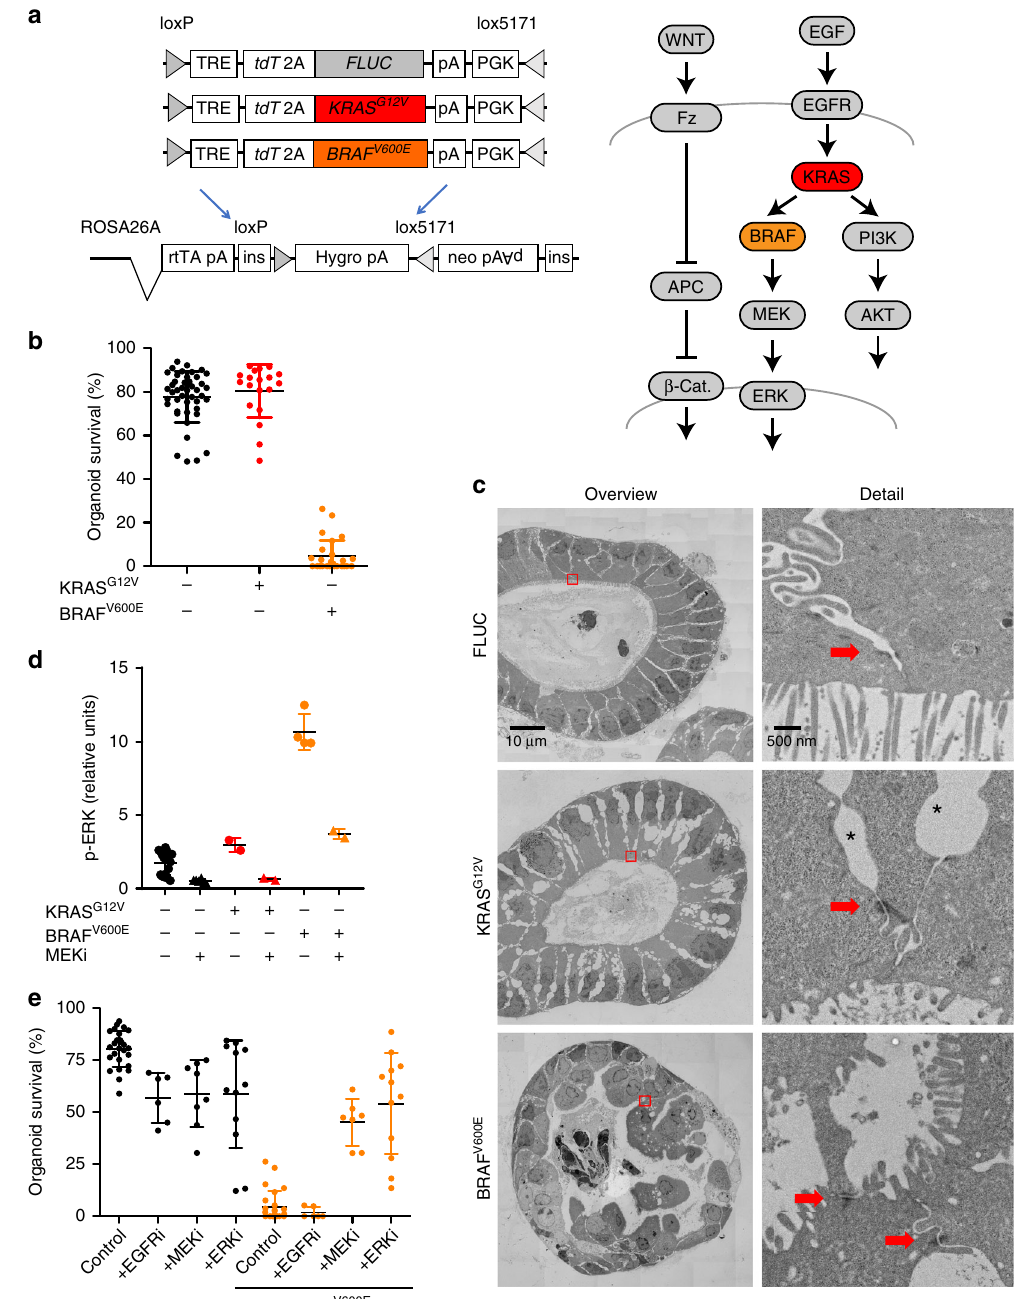
Fig. 2 Transgenic BRAF V600E , but not KRAS G12V disrupts organoids due to high ERK activity. a Simpli fi ed representations of transgenes and the RAS-ERK and Wnt/ β -catenin pathways, indicating relative positions of the KRAS and BRAF proto-oncogenes. b Organoid survival 4 days after induction of oncogenic KRAS G12V or BRAF V600E . Organoids are counted immediately after passaging, and fractions of surviving organoids were calculated at day 4. Control organoids comprise of mixed non-induced cultures of KRAS G12V and BRAF V600E lines. c Electron microscopy reveals loss of epithelial integrity after BRAF V600E induction. Images of the intestinal organoid epithelium, 24 h after induction of control FLUC, KRAS G12V or BRAFV 600E transgenes. Detailed views (right) represent a zoom into areas marked by red boxes in the overviews (left). Detailed views show apical surfaces of adjacent enterocytes with brush border. Red arrows mark desmosomes. Intercellular vacuoles, most visible in the KRAS G12V model (marked by *) are likely fi xation-induced artefacts, see ref. 27 . Scale bars are 10 µ m in the overview panels and 500 nm in the detailed view panels. d Quanti fi cation of ERK phosphorylation in organoids, 24 h after induction of control, BRAF or KRAS transgenes, using a capillary protein analysis. e Quanti fi cation of organoid survival, 4 days after inhibition of EGFR, MEK, ERK and/or induction of BRAF V600E , as in panel ( b ). Error bars in panels ( b ), ( d ) and ( e ) denote standard deviations. Data shown in panels ( b ), ( d ), and ( e ) are available as a Source Data fi